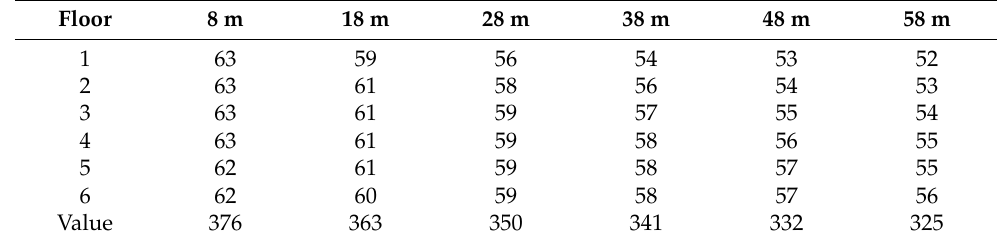
Table 8. Changes of SPL in each layer of the sound barrier under different setback conditions (Unit: dB(A)).